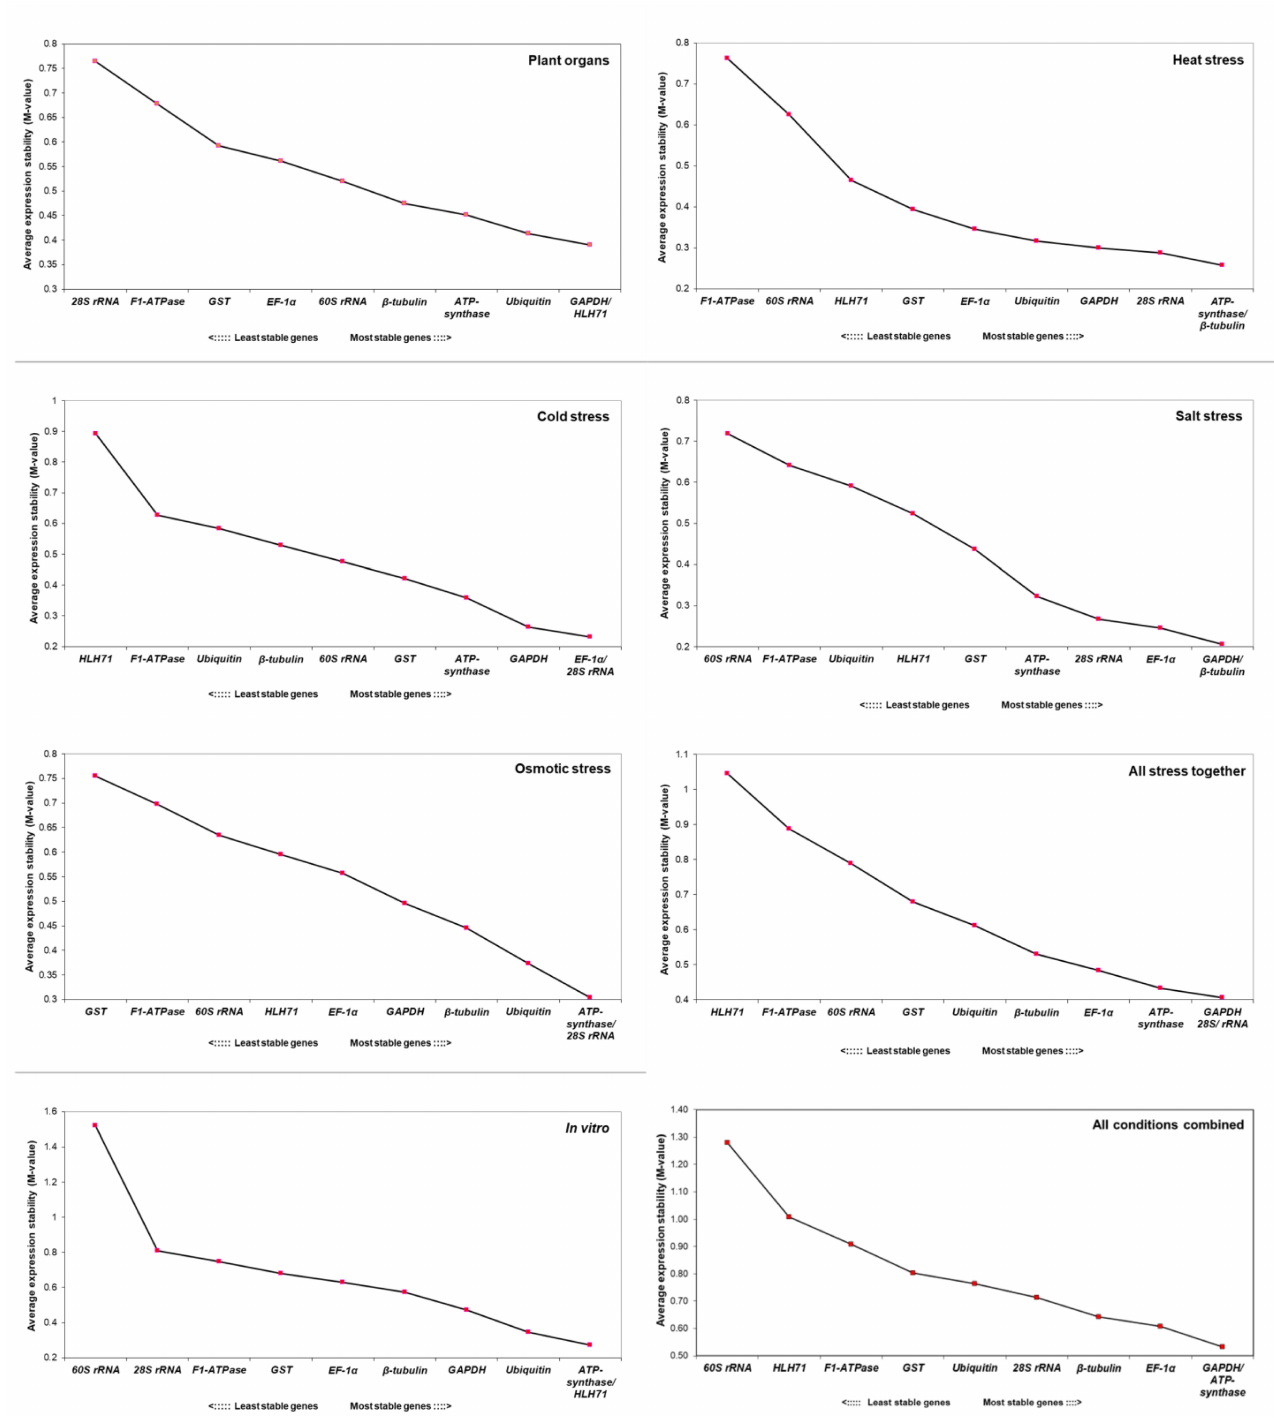
Figure 4. geNorm ranking of the candidate genes under different tested